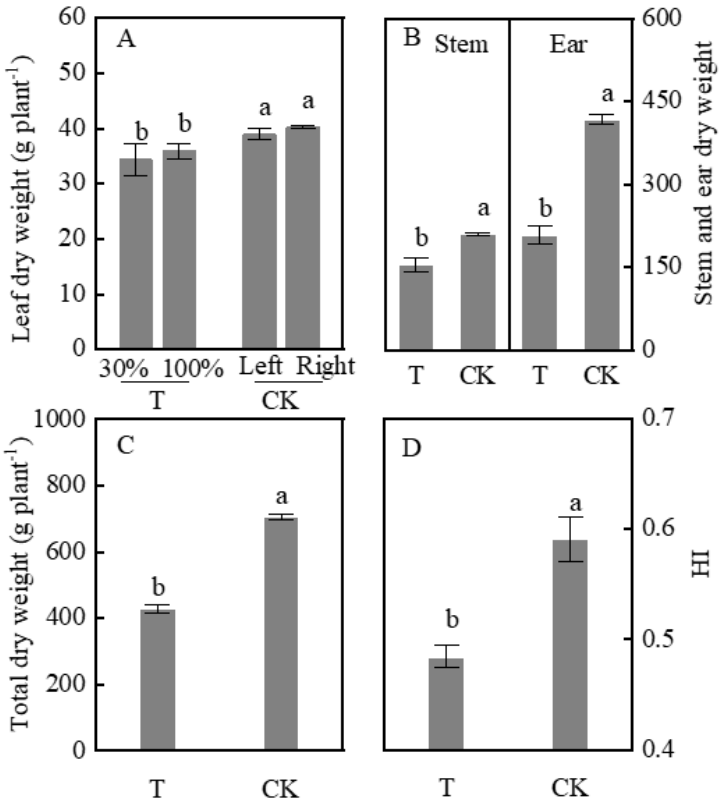
Figure 1. Leaf, stem, total dry matter weight and harvest indices (HI) in shading treatments. ( A ): leaf dry Figure 1 weight; ( B ): stem and ear dry weight; ( C ): total dry weight; ( D ): HI. Data are averages of three replicates, and bars represent standard errors. Plants grown under heterogeneous light (T), the left side leaves were under shade (T-30%) and right side leaf under natural light (T-100%). All leaves were under full sunlight (CK). Data with di ff erent letters are significantly di ff erent ( p <